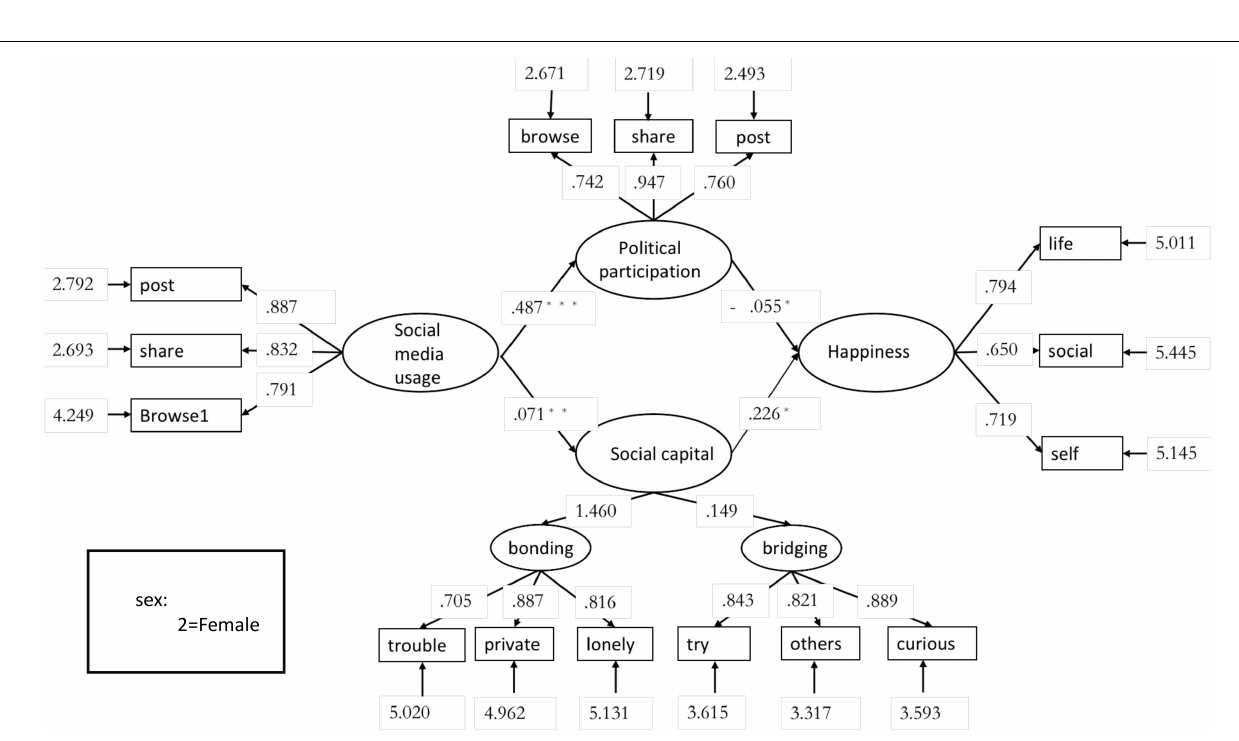
Frontiers in Psychology |